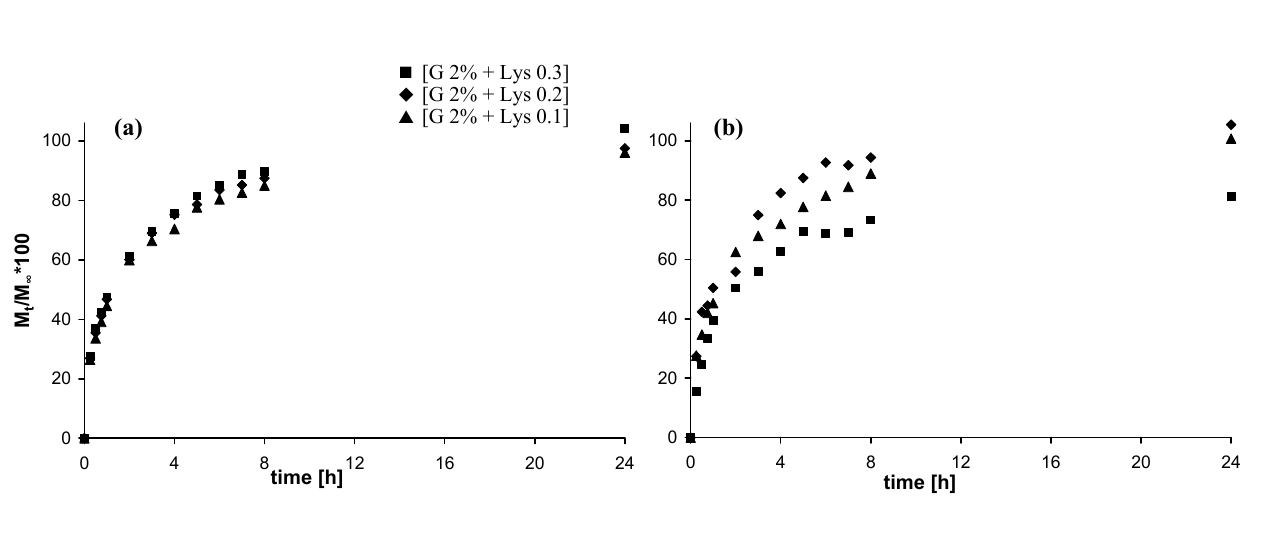
Figure 6. Release profiles (37 °C, SIF) of Vitamin B12: (a) from physical hydrogels; (b) from chemical hydrogels (in the legend G =